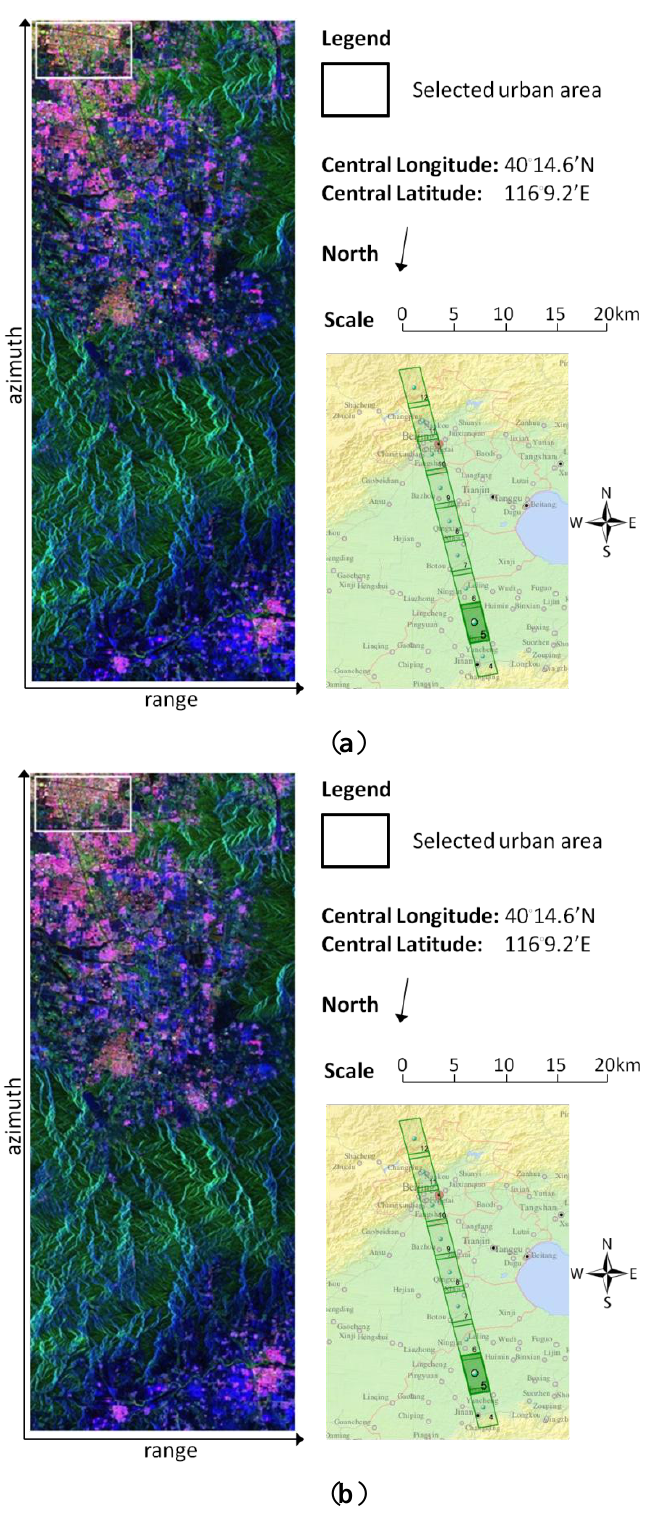
Figure 4. ( a ) Original Freeman-Durden decomposition result for ALOS-PALSAR data; ( b ) Proposed adaptive decomposition result for ALOS-PALSAR data; ( c ) Map of